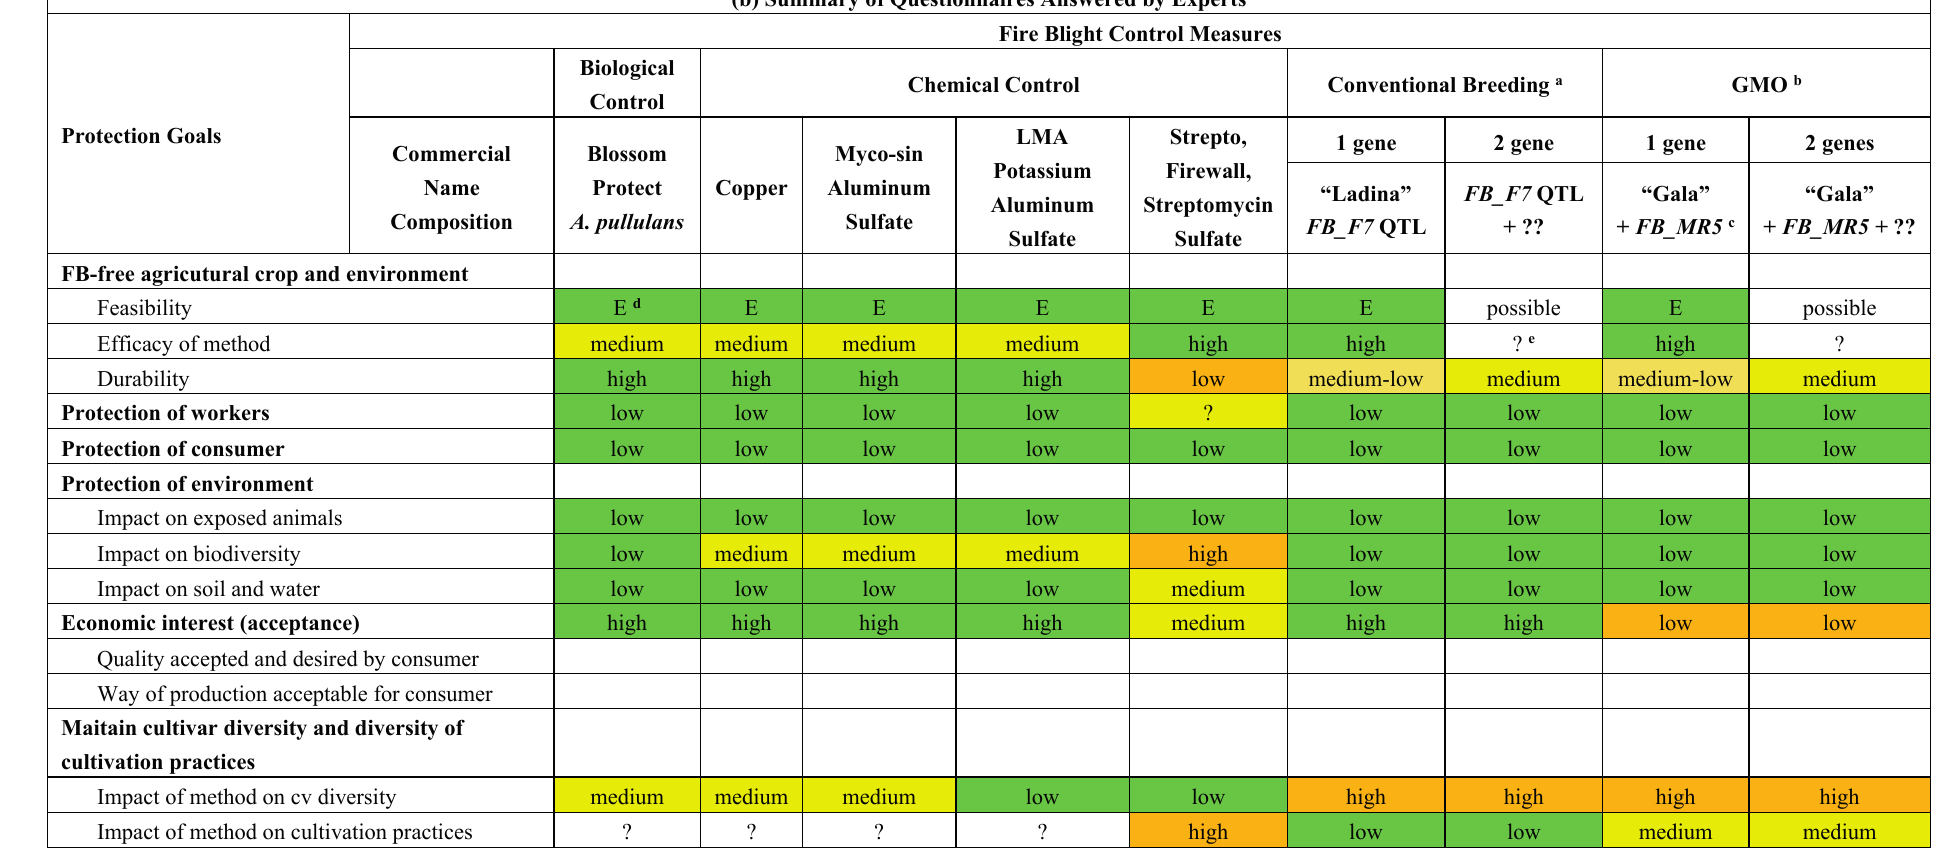
Table 3. Cont. (b) Summary of Questionnaires Answered by